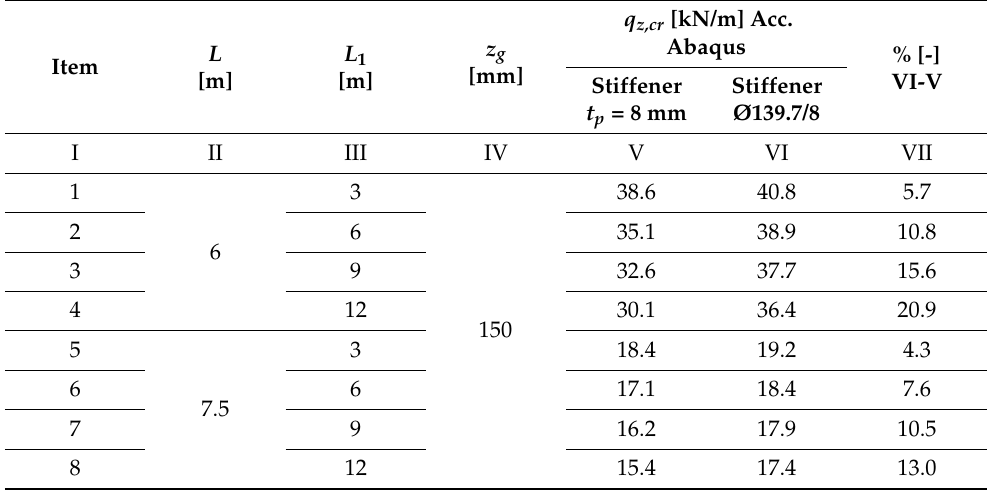
Table 1. The ECR ( q z,cr ) of H-type grillage from the condition of lateral torsional buckling of the main (critical) beam B–E, uniformly loaded ( z g = + h /2), from Abaqus (solid